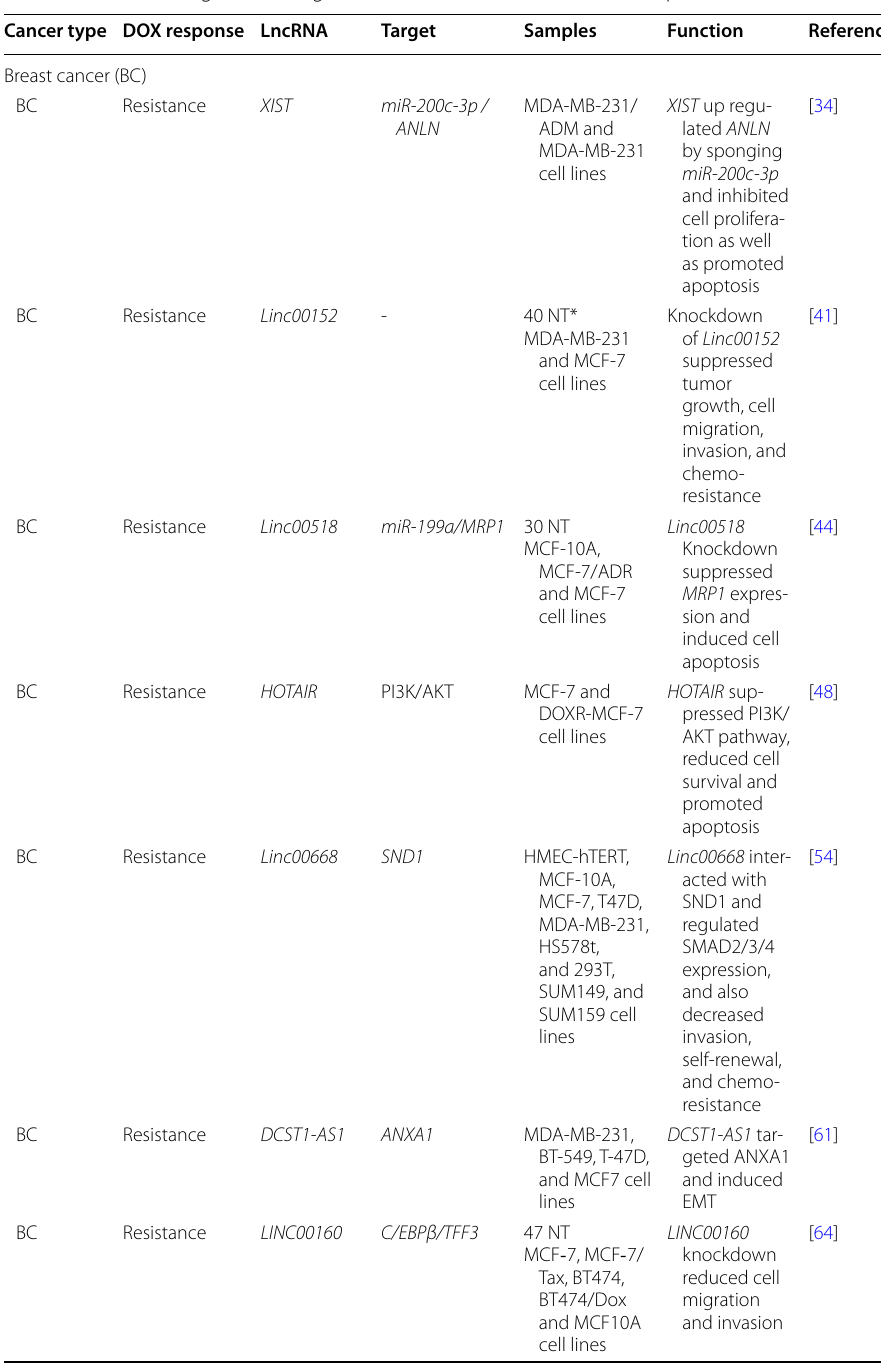
Table 1 All of the long non‑coding RNAs associated with Doxorubicin response in different cancers Cancer type DOX response